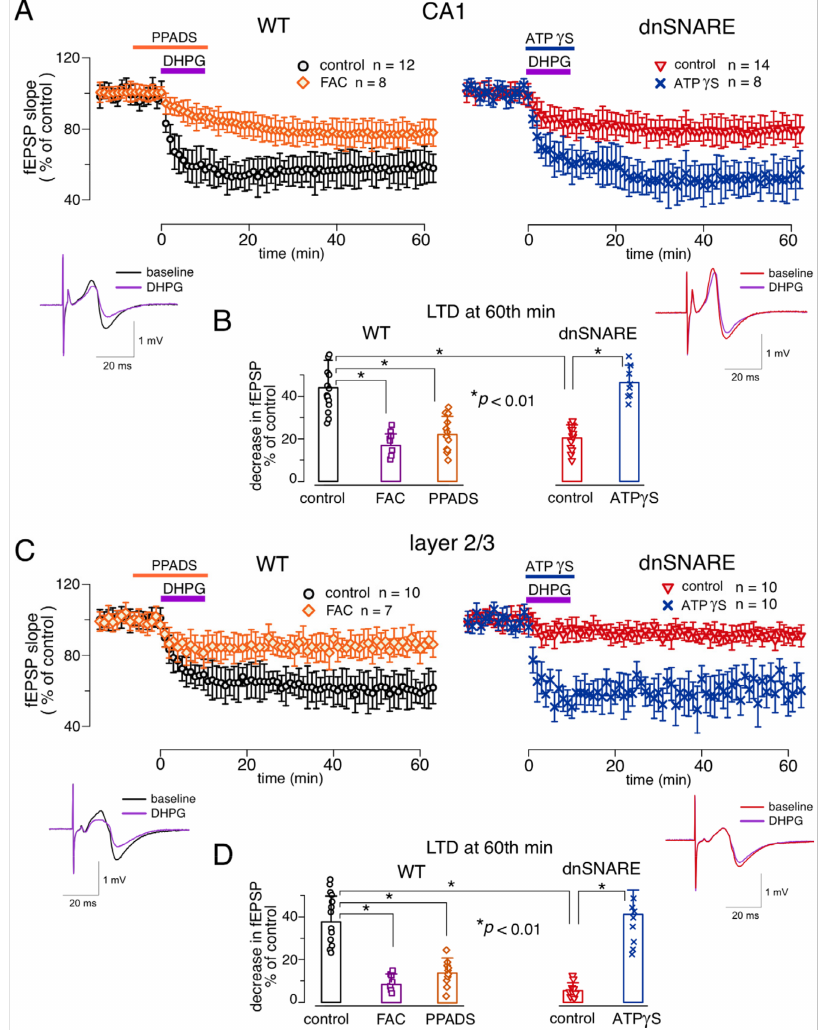
Figure 3. Astroglial exocytosis and P2X receptors are essential for the DHPG-induced LTD in the hippocampus and neocortex. ( A ) The time course of changes in the field excitatory postsynaptic potential (fEPSP) in the CA1 region of the wild-type (left) and dnSNARE (right) mice induced by the application of DHPG either under control conditions or in the presence of PPADS or ATP γ S. Dots show the average slope (relative to baseline) for 1 min-window (6 fEPSPs); data are shown as mean ± s.d. for number of experiments indicated. The insets show the representative fEPSP waveforms (average of 10 fESPs) recorded in individual experiments before (baseline) and 30 min after DHPG application under control conditions. ( B ) The magnitude of LTD evaluated as a relative decrease in the fEPSP slope at 60th min (after start of DHPG application), averaged over 10 min time window. Points show individual experiments, bars show mean ± SD. Asterisks (*) indicate the significance of difference from the control of same genotype and difference between the genotypes. ( C , D ) same experimental paradigm was applied to the fEPSPs recorded in the somatosensory cortex layer 2/3 of WT and dnSNARE mice. Both in the CA1 and layer 2/3, note the attenuation of LTD by P2 antagonist PPADS and the rescue of LTD in the dnSNARE mice by P2X agonist ATP γ S. Similarly to the DHPG-induced LTD, synaptic depression induced by the paired- pulse stimulation showed dependency on the gliotransmission and P2 purinoreceptors, both in the hippocampus and neocortex (Figure 4). Under control conditions, the relative magnitude of PPLFS-induced depression of fEPSPs in the CA1 are of wild-type mice reached 56 ± 16% ( n = 12); the PPLFS-induced depression in the layer 2/3 synapses reached 48.5 ± 15.1% ( n =